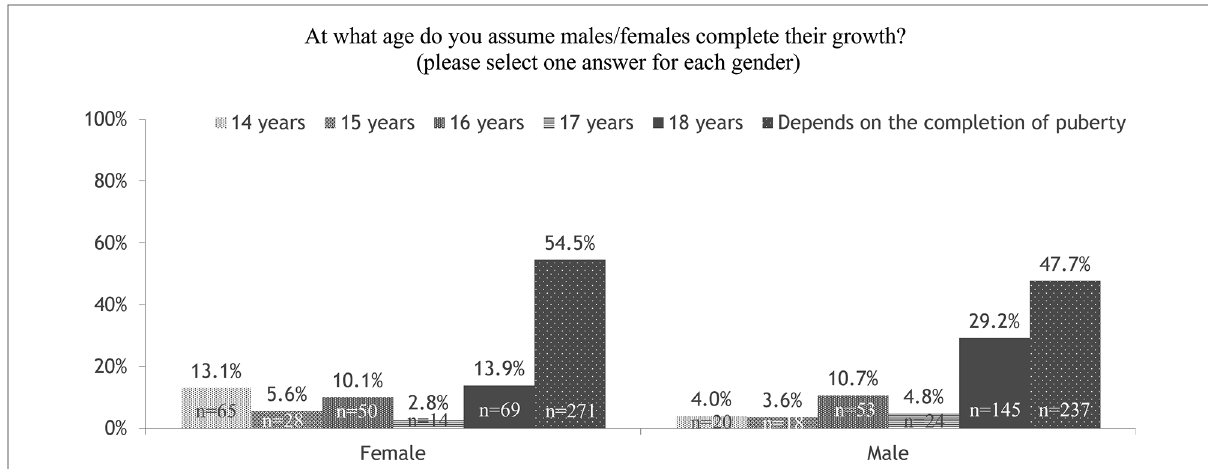
FIGURE 5 Survey responses to “ At what age do you assume males/females complete their growth? ” . GH, growth